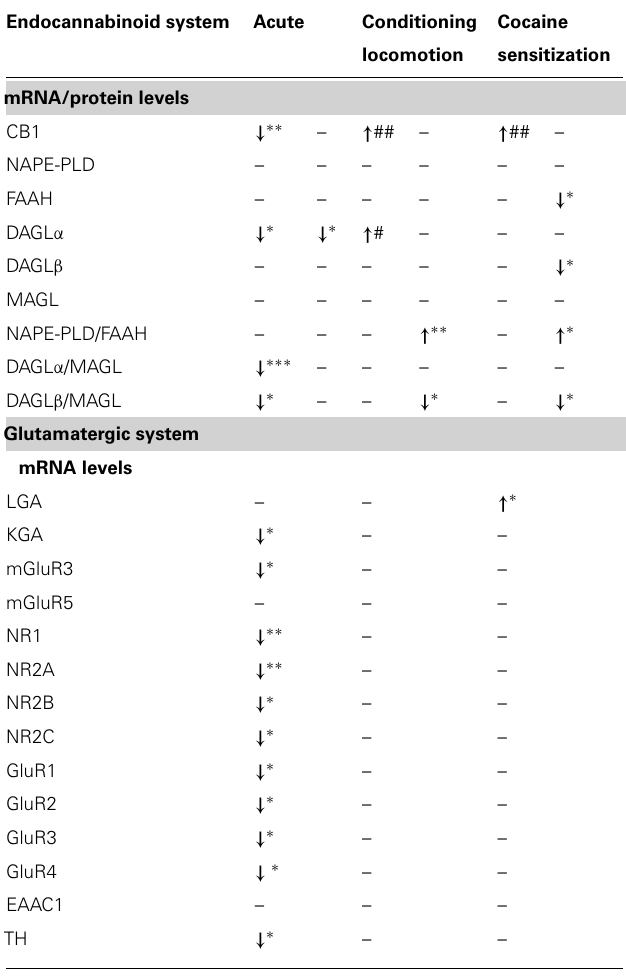
Table 2 | Summary of the main effects observed on the endocannabinoid and glutamate systems after acute cocaine, conditioning locomotion, and cocaine sensitization 1